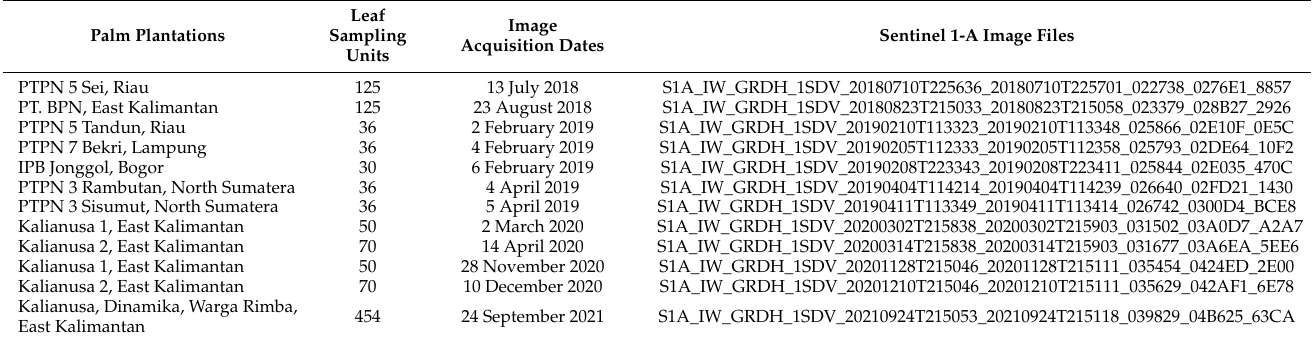
Table 4. Sentinel 1A image acquisition location and